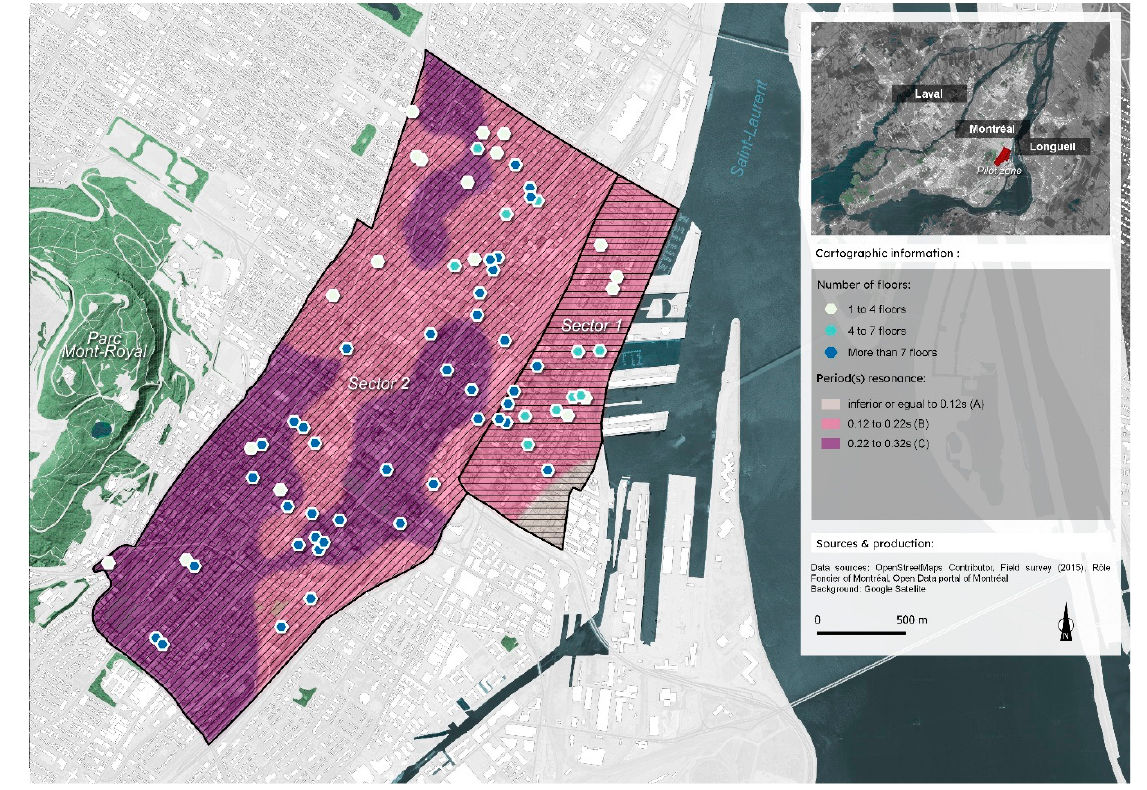
Figure 4. Zonation in terms of the resonance period of the soil T (in s) based on the map from Rosset and Chouinard [23].